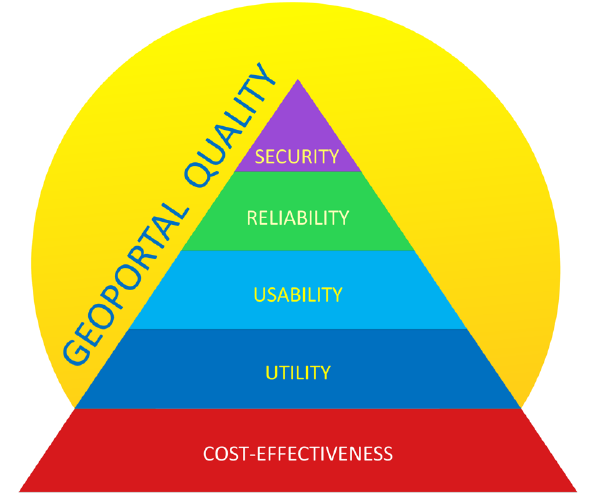
Figure 2. A hierarchy of the most important constraints for academic